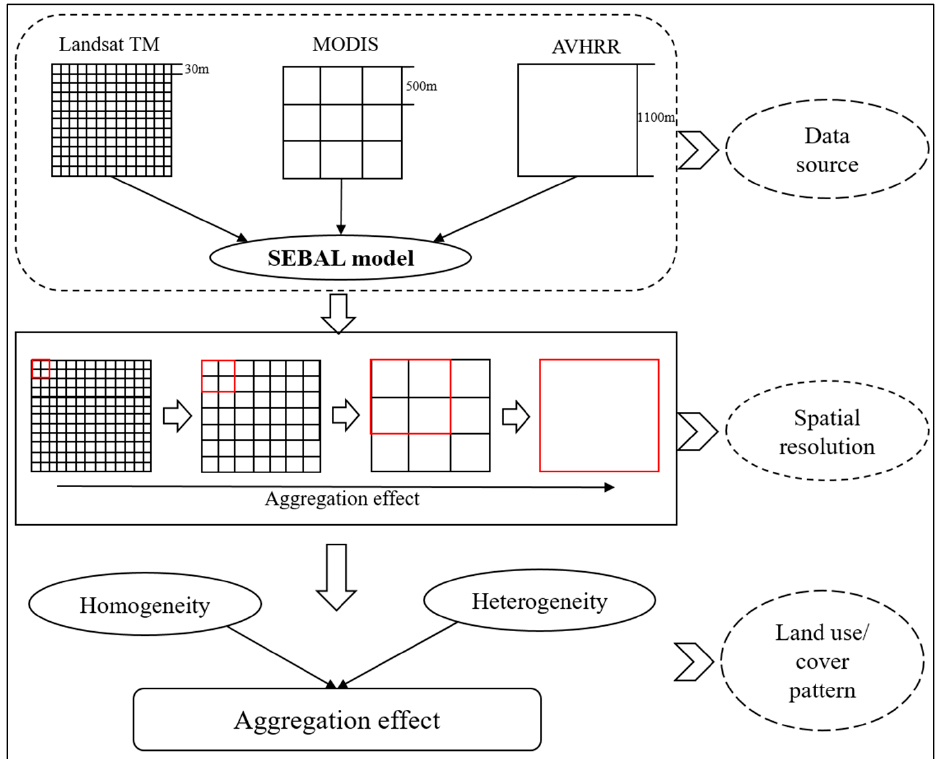
Figure 3. Flowchart of the ET simulation and aggregation processes. Landsat TM is Landsat Thematic Mapper, MODIS is Moderate Resolution Imaging Spectroradiometer, and AVHRR is Advanced Very High-Resolution Radiometer.